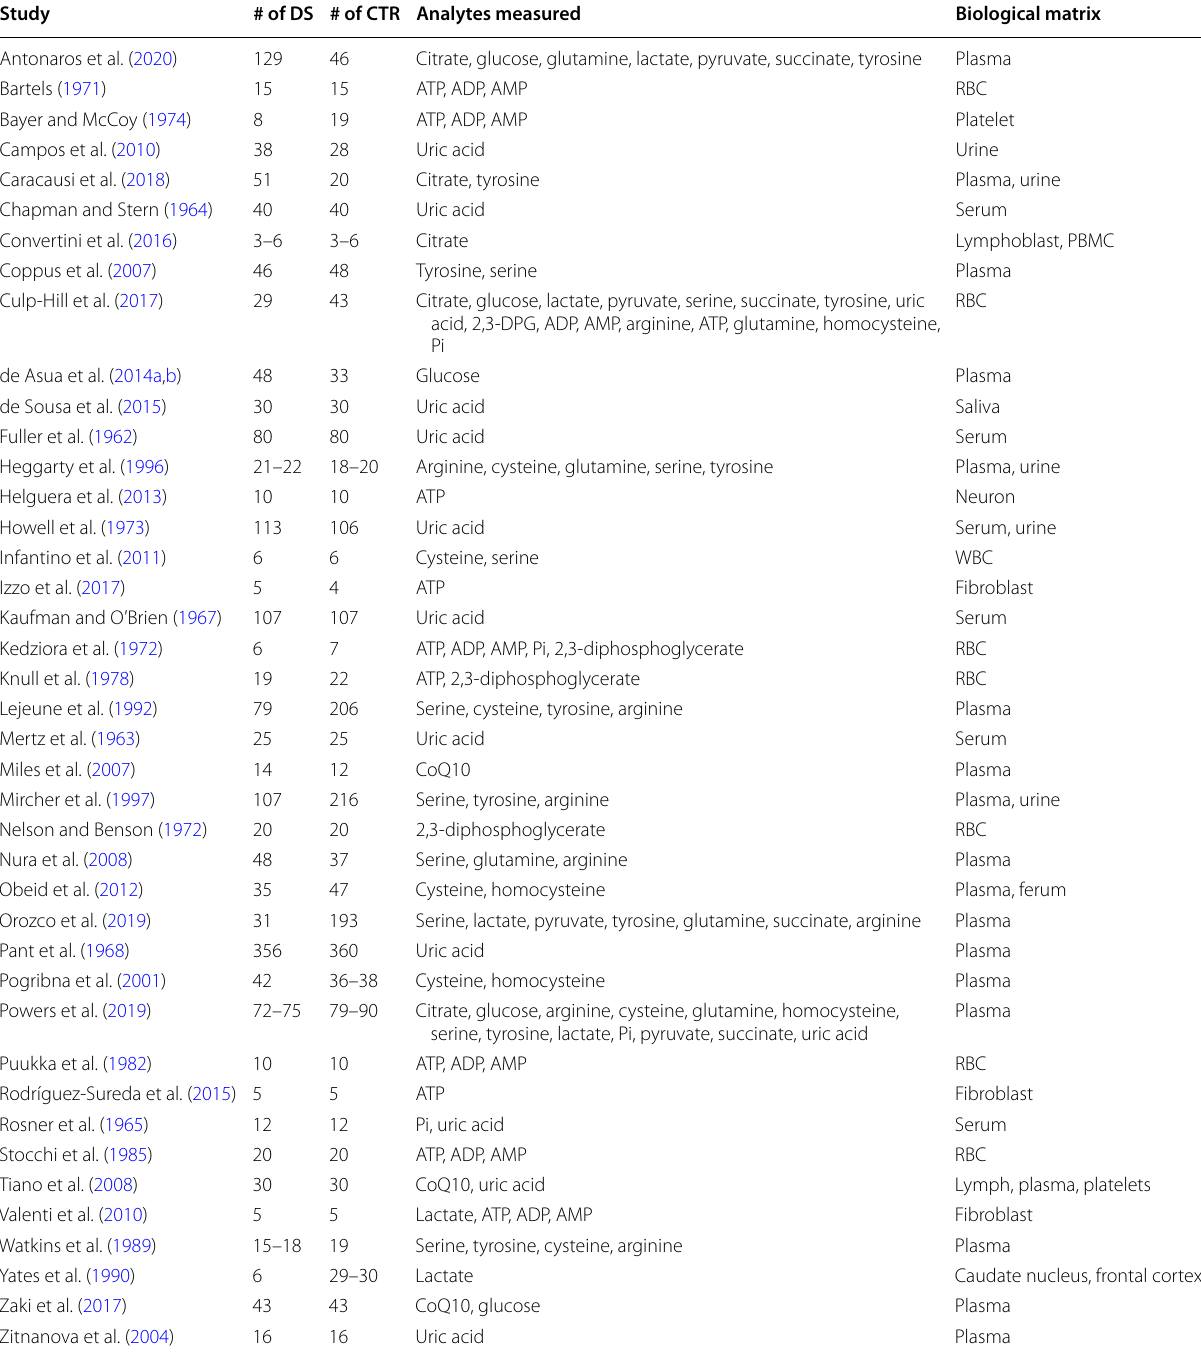
Table 1 Studies selected for